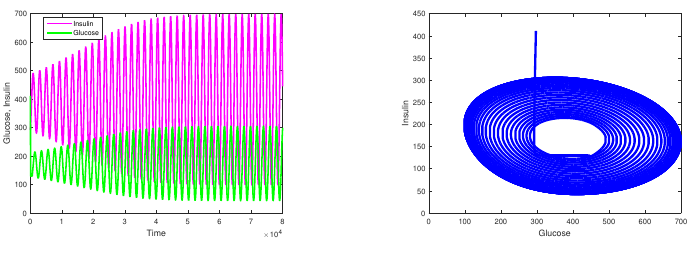
Figure 15. Glucose-insulin dynamics: dynamics and phase plain for τ i = 550 > τ ∗ = 500 i